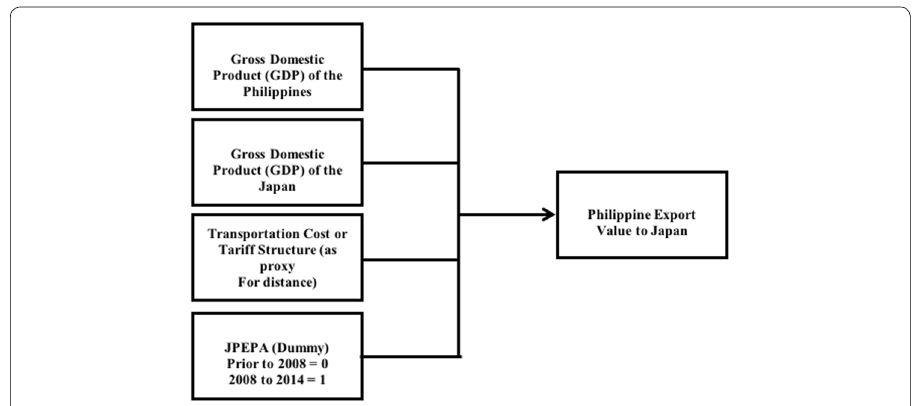
Fig. 1 The gravity model of Philippines–Japan trade